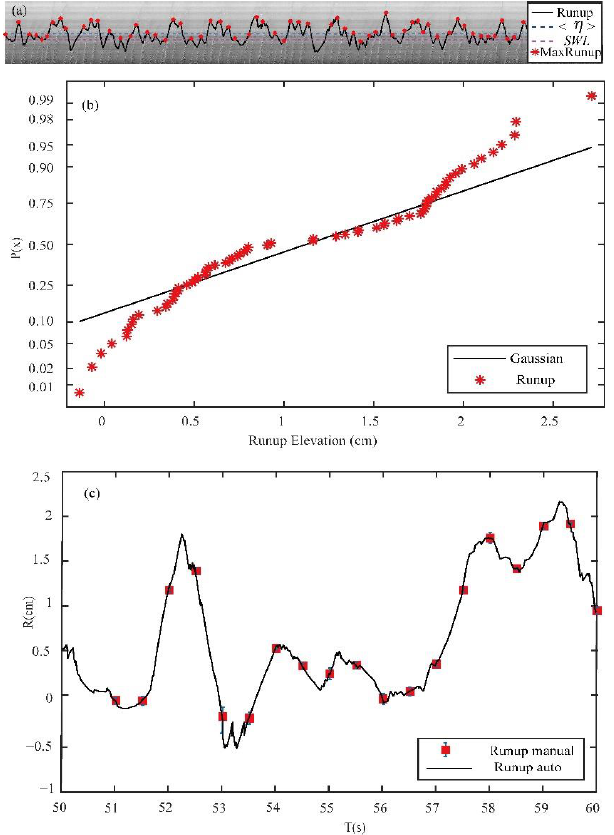
Figure 4. Example of time-stack image: ( a ) time-stack image with runup edge (black solid line), wave set-up (blue dotted line), SWL (carmine dotted line), and max runup (red star marker); ( b ) probability cumulative distribution of individual wave runup (red points) and Gaussian distribution (black solid line); ( c ) automatic wave runup time series compared with a manual process.